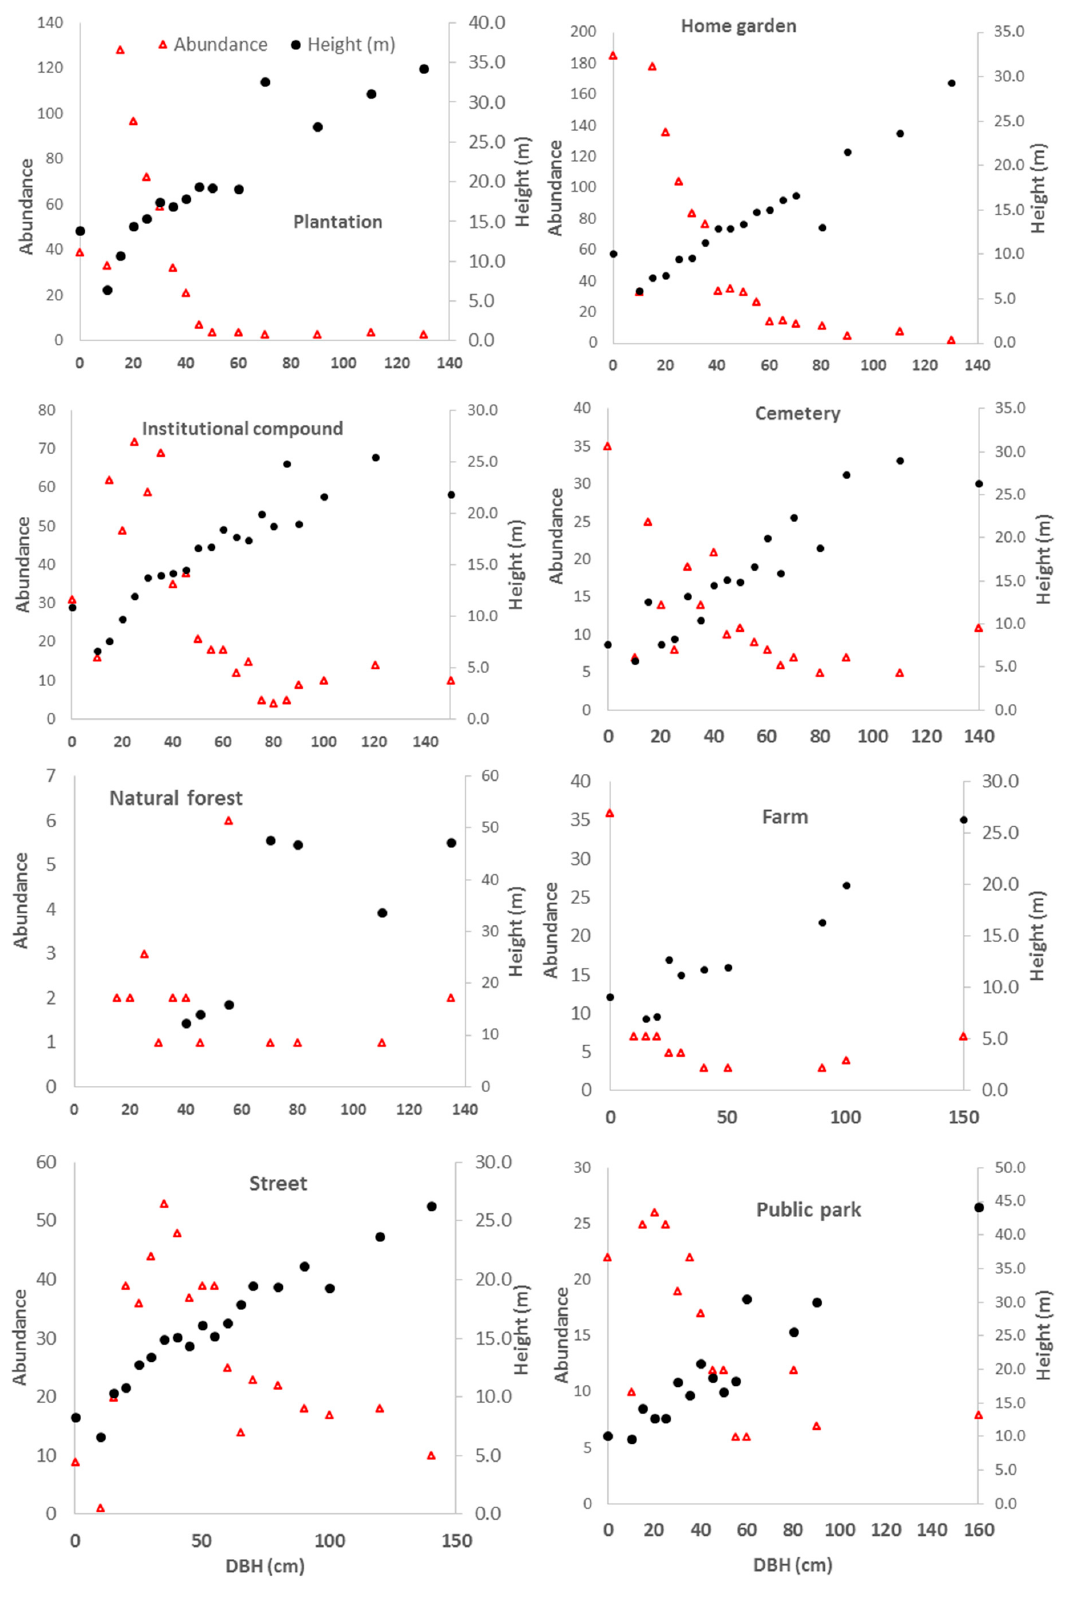
Figure 5. The abundance and mean total height of trees in different diameter at breast height (DBH) classes among green spaces of Kumasi, Ghana.